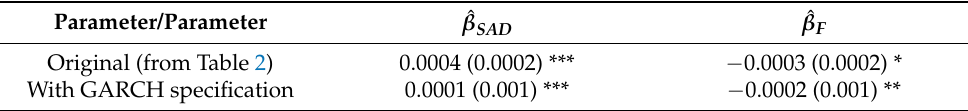
Table 4. Robustness check of results for Model 2.